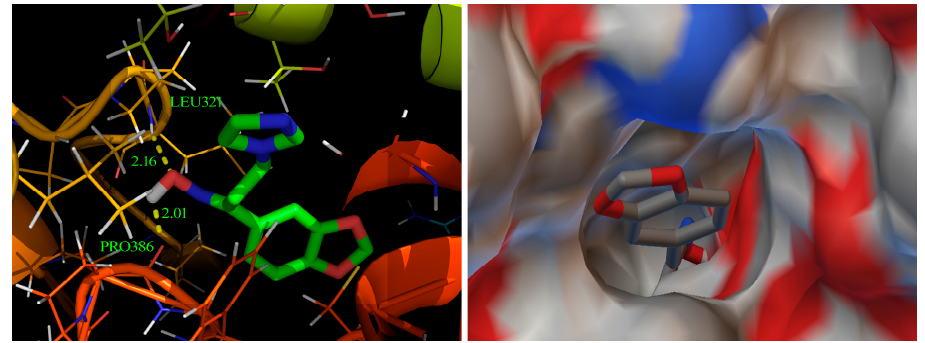
Figure 7. Binding pose of compound 4 with its target protein.